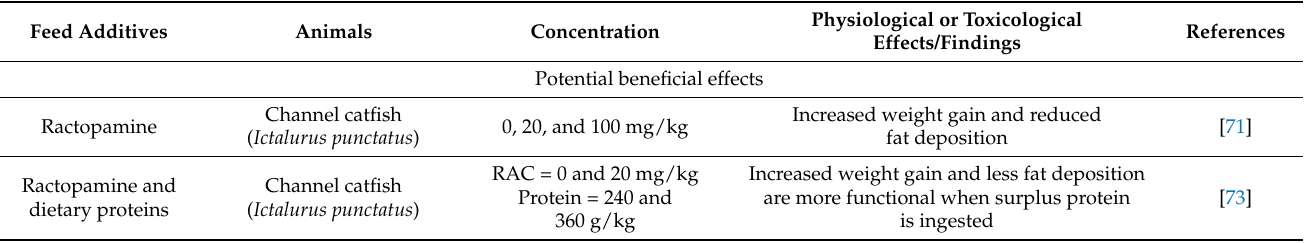
Table 2. Summary of the physiological and toxicological effects of RAC administration in